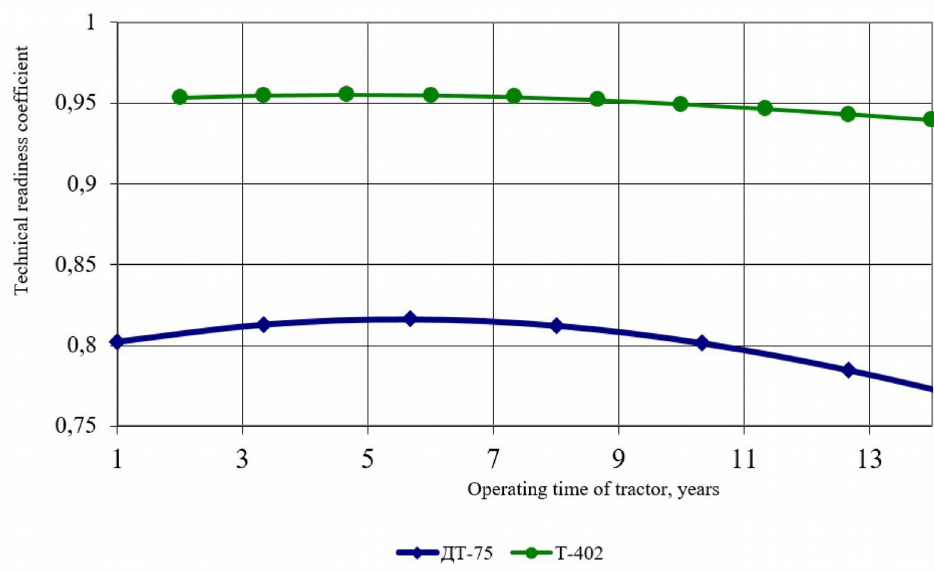
Figure 3. Dynamics of changes in the technical readiness of tractors (based on the results of neural network